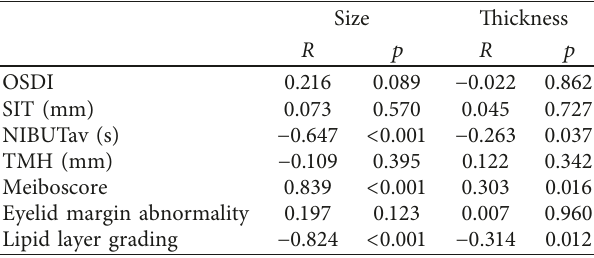
Figure 2: (a) Anterior segment SD-OCT horizontal OCTscan (parallel to the axis of the midpoint of the cornea on the nasal and particular sides) of a primary pterygium. (b) Anterior segment SD-OCT measures the thickness of pterygium at 1mm in the limbus. The primary pterygium is the overgrown section attached to the cornea. The value of 251 μ m represents the thickness of the pterygium at 1mm in the limbus. The pterygium is present between the two arrows. Table 2: Correlations between the pterygium parameters, dry eye indices, and meibomian gland